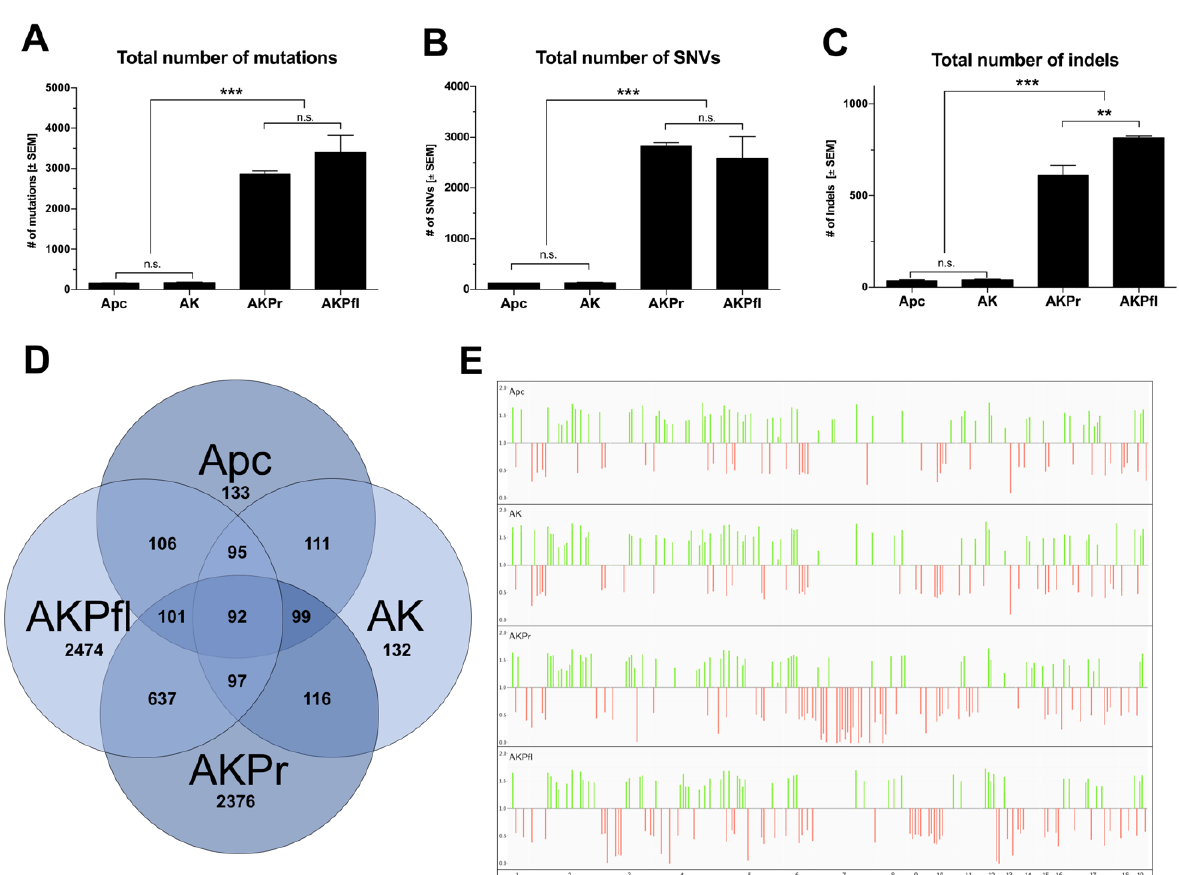
Figure 5. Number of mutations increase considerably in Trp53 -alterated tumors. ( A – C ) Total number of mutations, SNVs and INDELs in tumors of all genotypes. ( D ) Overlapping mutations (TCGA>1%) in all genotypes (Table S3 for list). ( E ) Copy number alterations in all genotypes. Green: gains. Red: losses. ** p < 0.01; *** p < 0.001; n.s.: not significant. Apc, Apc fl/fl mice; AK, Apc fl/fl / Kras LSL-G12D/+ mice; AKPr, Apc fl/fl / Kras LSL-G12D/+ / Trp53 LSL-R172H/+ mice; AKPfl, Apc fl/fl / Kras LSL-G12D/+ / Trp53 fl /fl